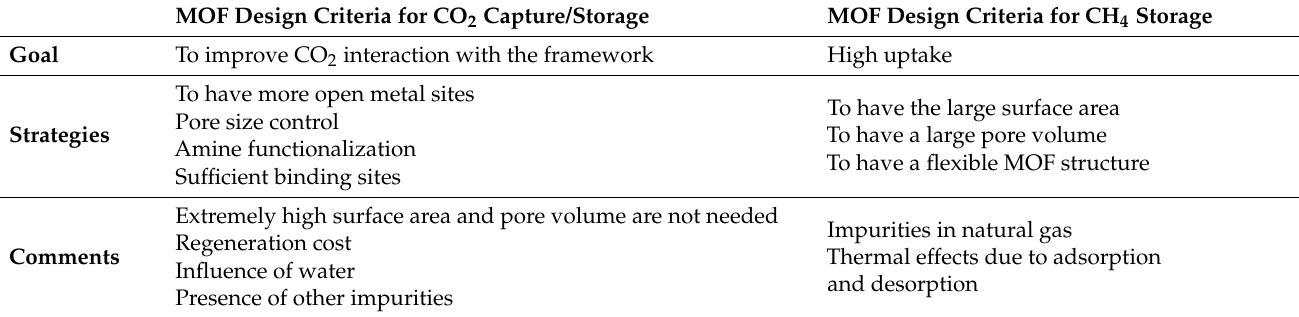
Figure 6. Possible decision matrix concerning the selection of MOFs for MOF–hydrate synergy. Table 1. Differences in MOF design criteria as an adsorbent for CO 2 capture and CH 4 storage [43].